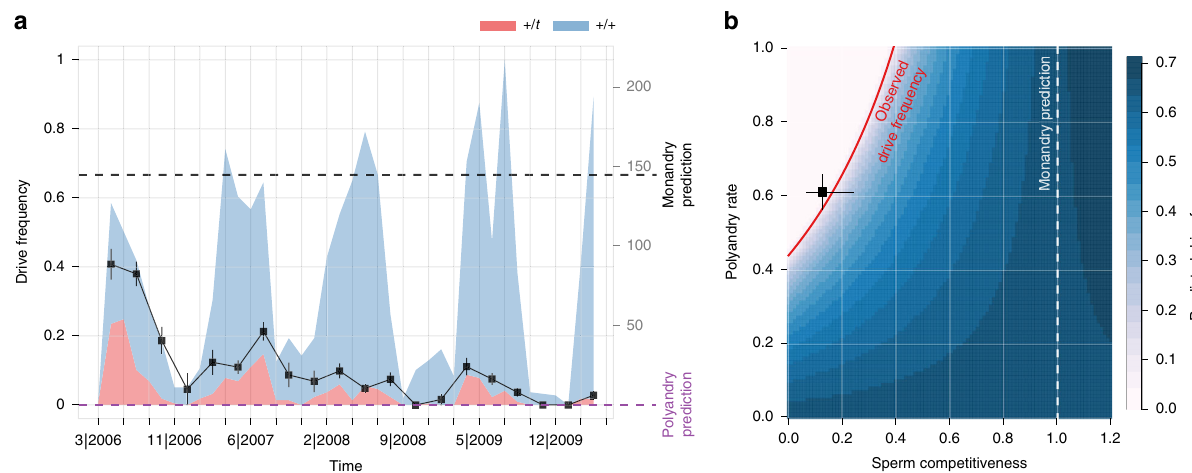
Fig. 3 The impact of polyandry on drive frequency dynamics. Observed t frequencies in the study population were lower than expected by monandry, but are in line with polyandry model predictions. a The frequency of + /t heterozygotes among 3126 offspring over the 4.5 year observation period in relative (black squares and lines for mean and binomial standard error, respectively) and absolute numbers (blue/red shaded areas). The grey dotted line shows the expected 66% + /t genotypes expected under monandry. The violet dashed line denotes the 0% prediction based on observed levels of polyandry and + / t male sperm competitive disadvantage. The polyandry model correctly predicts the observed frequency trend. b Predicted and observed + / t genotype frequency as a function of + /t male sperm competitiveness and polyandry rate (for drive strength d = 0.9) based on the polyandry model (Supplementary Note 3). The dotted line denotes the monandry prediction of 66% (where + /t males have no sperm competition disadvantage). The red curve corresponds to the average observed drive genotype frequency during the observation period (11.8%). The square with horizontal and vertical lines shows the empirically measured mean and 95% con fi dence intervals for both parameters (Supplementary Note 4, polyandry rate: 682 litters, sperm competitiveness 11 : 57 mating trials). Again, observed genotype frequencies agree with the (parameterised) polyandry model, but do not align with the monandry prediction. Source data of observed + /t genotype frequency are provided as a Source data fi